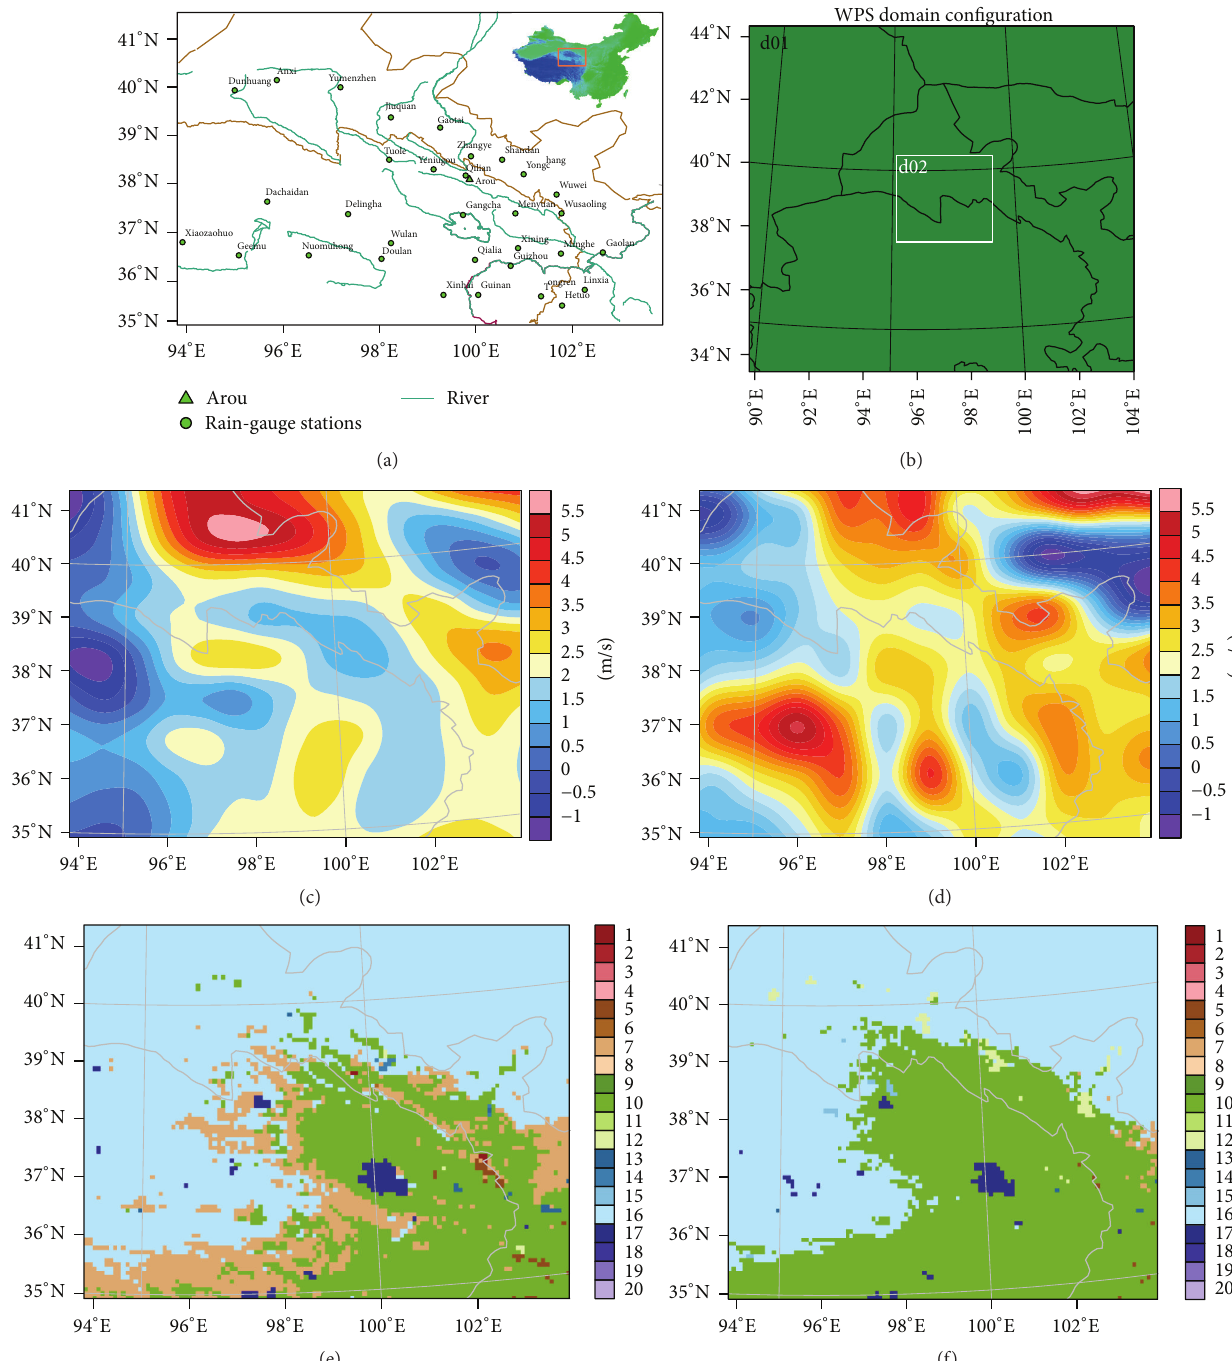
Figure 1: Study area, initial field, and land surface information: (a) 43 stations on northeastern Tibetan Plateau; (b) two-way nested domains in the WRF model; (c) U10 in NCEP FNL; (d) U10 in ERA-Interim; (e) MODIS-based land-use data in 2001; (f) MODIS-based land-use data in 2010. In (e) and (f), the land-use categories are as follows: 1: evergreen needleleaf forest; 2: evergreen broadleaf forest; 3: deciduous needleleaf forest; 4: deciduous broadleaf forest; 5: mixed forests; 6: closed shrublands; 7: open shrublands; 8: woody savannas; 9: